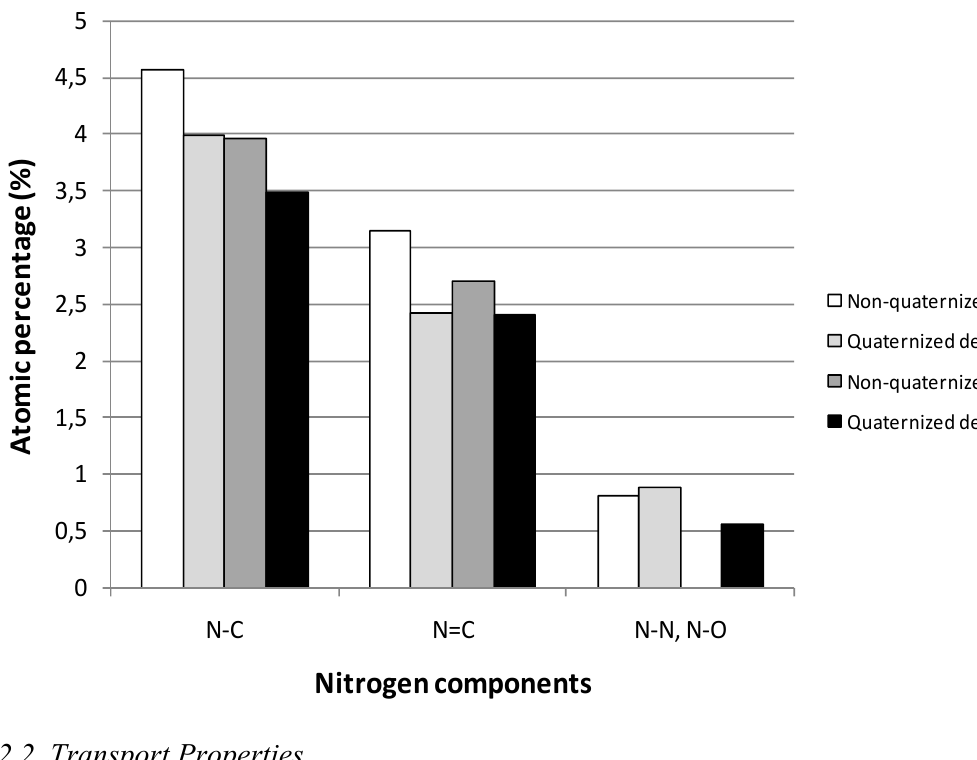
Figure 8. Evolution of the different components of the N quaternization, both at the surface (without erosion) and in the bulk (after erosion). Plasma deposition was performed in the following conditions: P τ = 10 min. XPS analyses were performed on the ESCALAB 250